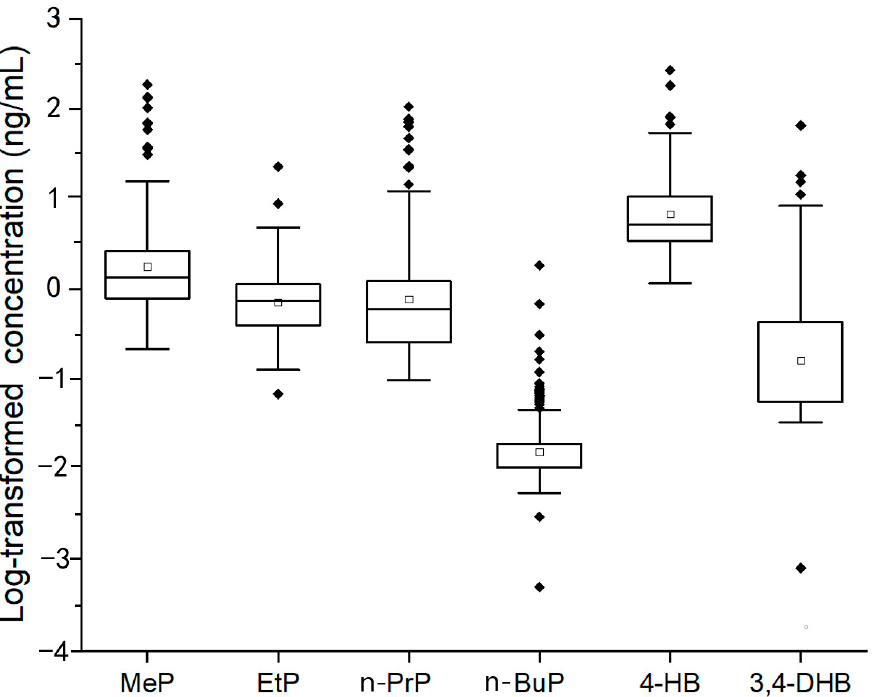
Figure 2. The levels of 4 parabens (MeP, EtP, n-PrP, and n-BuP) and their metabolites (4-HB and 3,4-DHB) in 144 seminal plasma samples (ng/mL).